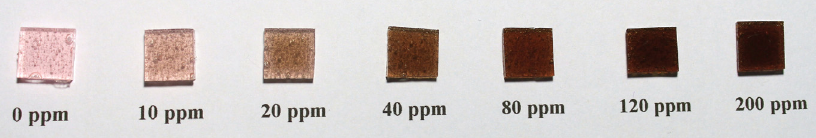
Figure 2. Polymerized material samples: Ufi Gel SC (UG) and composites with different AgNP concentrations.